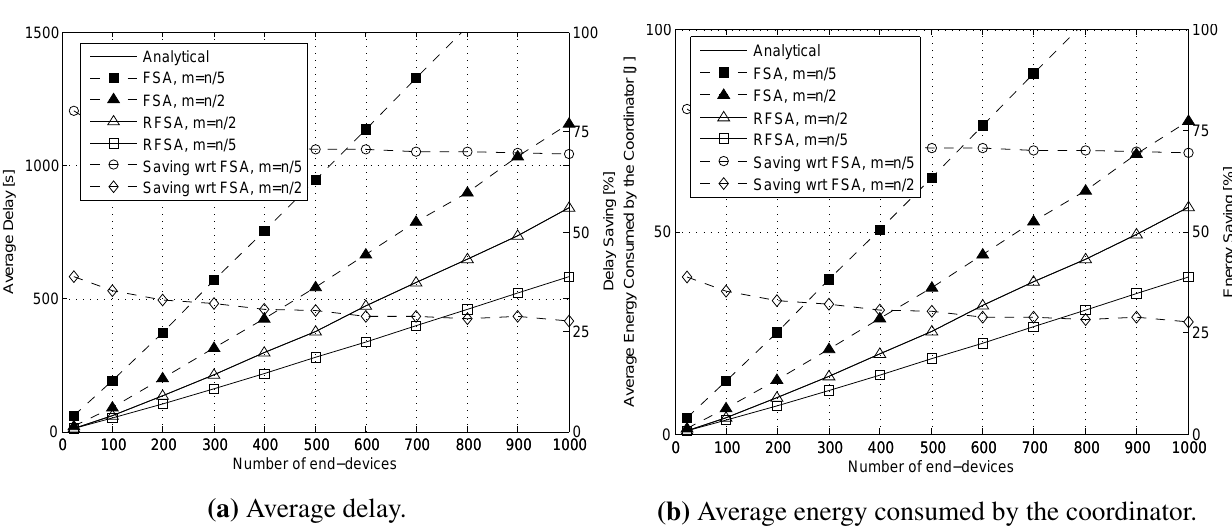
Figure 6. ( a ) Average delay (left vertical axis) to terminate a data collection round using m = n/ 2 and m = n/ 5 slots per frame; and ( b ) average energy consumption (left vertical axis) of the coordinator in a data collection round using m = n/ 2 and m = n/ 5 slots per frame. The delay and energy savings provided by RFSA with respect to FSA are shown in the right vertical